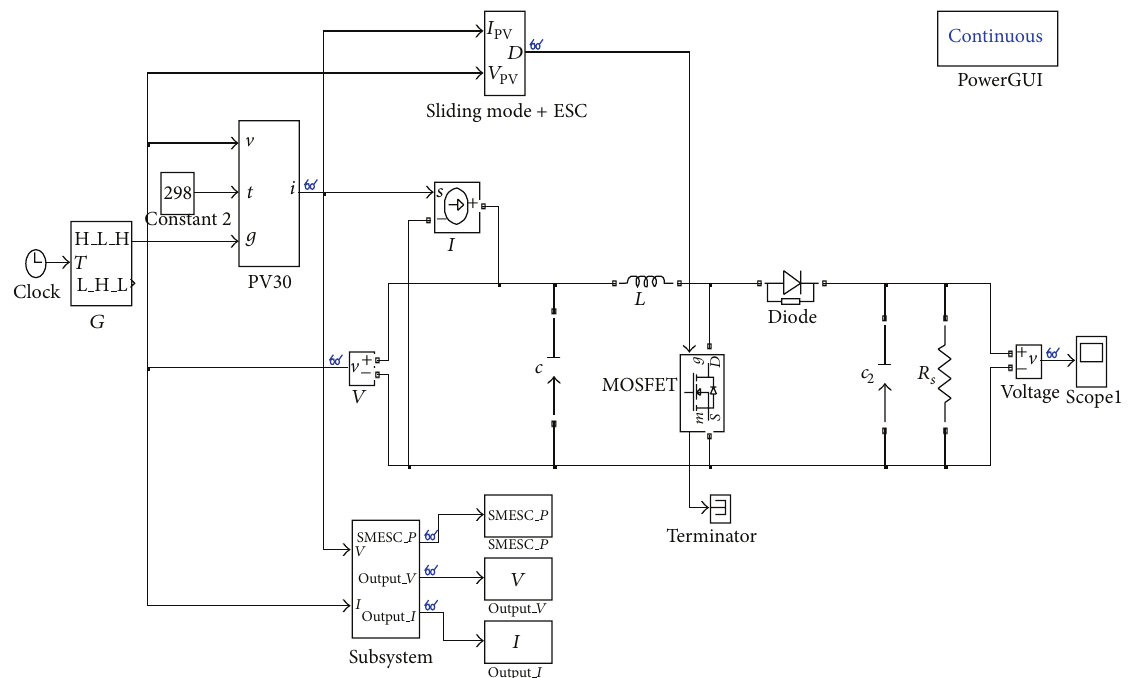
Figure 9: SMESC simulation model.